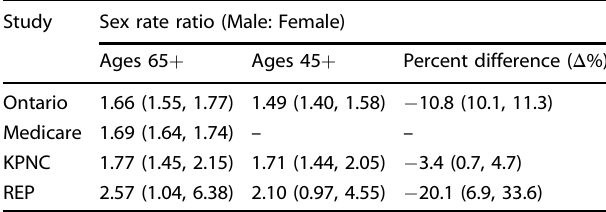
Fig. 1 Age- and Sex-Speci fi c Incidence Rates of PD. Age-Speci fi c Incidence Rates per 100 000 Person-years for (panel A ) Females and (panel B ) Males of: Treated Parkinsonism in the Ontario population (1,974,100 person-years, 2012); Treated Parkinsonism in the U.S. Medicare Insured population (6,866,623 person-years, 2012); Treated, Neurologist Reviewed Parkinson Disease in the Kaiser Permanente Northern California (KPNC) Insured Population (322,535 person-years, 2012); Movement Disorders Specialist Consensus Parkinson Disease in the Honolulu Asian Aging Study (HAAS) Cohort (138,806 person-years, 2011). Table 3. Male to female ratio, age-standardized PD incidence,